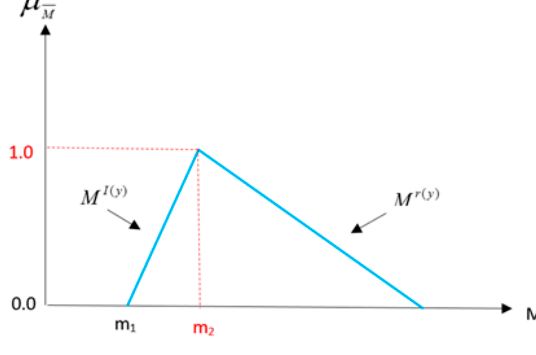
Figure 8. The triangular fuzzy set.